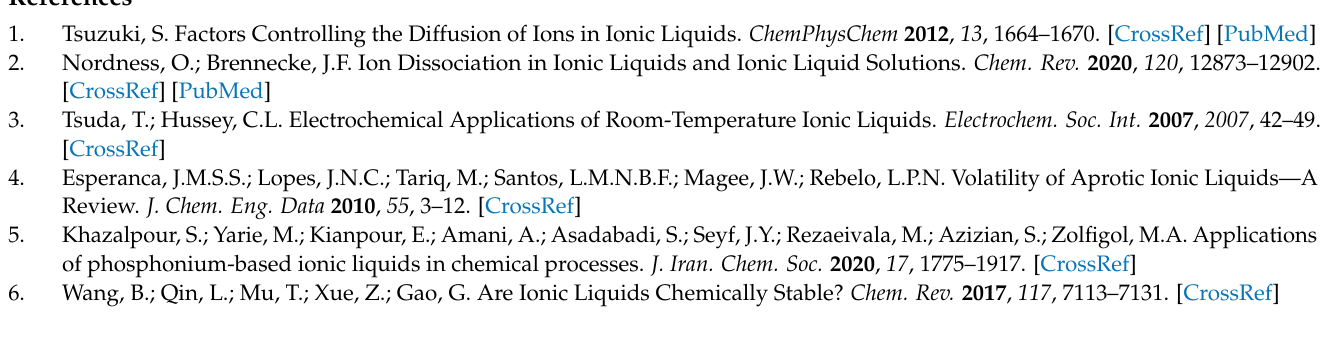
at U max, pol . Figure S15: Microscopy images of the samples [201b] (a) and [201b-025] (b) after 30 h polarization at U max, pol . Figure S16: Microscopy images of the samples [202b] (a) and [202b-025] (b) after 30 h polarization at U max, pol . Figure S17: Linear voltammetry scan of Al vs. Li cells from 3.0 to 5.5 V vs. Li/Li + of (a) n-alkyl phosphonium ionic liquids and (b) n-alkyl phosphonium ionic liquid salt mixtures. Figure S18: Linear voltammetry scan of Al vs. Li cells from 3.0 to 5.5 V vs. Li/Li + of (a) ether containing phosphonium ionic liquids and (b) ether containing phosphonium ionic liquid salt mixtures. Figure S19: Microscopy images of the aluminum sheets including alcyl phosphonium IL and IL/salt electrolytes after the CV experiment. Figure S20: Microscopy images of the aluminum sheets including ether containing phosphonium IL and IL/salt electrolytes after the CV experiment. Figure S21: Cyclic voltammetry (CV) measurement of Al//Li cells between 3.0–5.5 V vs. Li/Li + of cycle 1 and cycle 10 of electrolyte [4a] (a) and electrolyte [4a_025] (b). Figure S22: Cyclic voltammetry (CV) measurement of Al//Li cells between 3.0–5.5 V vs. Li/Li + of cycle 1 and cycle 10 of electrolyte [5a] (a) and electrolyte [5a_025] (b). Figure S23: Cyclic voltammetry (CV) measurement of Al//Li cells between 3.0–5.5 V vs. Li/Li + of cycle 1 and cycle 10 of electrolyte [2O1a] (a) and electrolyte [2O1a_025] (b). Figure S24: Cyclic voltammetry (CV) measurement of Al//Li cells between 3.0–5.5 V vs. Li/Li + of cycle 1 and cycle 10 of electrolyte [2O2a] (a) and electrolyte [2O2a_025] (b). Figure S25: Cyclic voltammetry (CV) measurement of Al//Li cells between 3.0–5.5 V vs. Li/Li + of cycle 1 and cycle 10 of electrolyte [4b] (a) and electrolyte [4b_025] (b). Figure S26: Cyclic voltammetry (CV) measurement of Al//Li cells between 3.0–5.5 V vs. Li/Li + of cycle 1 and cycle 10 of electrolyte [5b] (a) and electrolyte [5b_025] (b). Figure S27: Cyclic voltammetry (CV) measurement of Al//Li cells between 3.0–5.5 V vs. Li/Li + of cycle 1 and cycle 10 of electrolyte [2O1b] (a) and electrolyte [2O1b_025] (b). Figure S28: Cyclic voltammetry (CV) measurement of Al//Li cells between 3.0–5.5 V vs. Li/Li + of cycle 1 and cycle 10 of electrolyte [2O2b] (a) and electrolyte [2O2b_025] (b). Figure S29. Cycle test in half cell configuration. Figure S30: Cycle test in full cell configuration. Figure S31: dQ/dU during the first cycle for measuring the overpotential. Figure S32: Comparison of ammonium and phosphonium-based electrolytes in NMC vs. Li cell